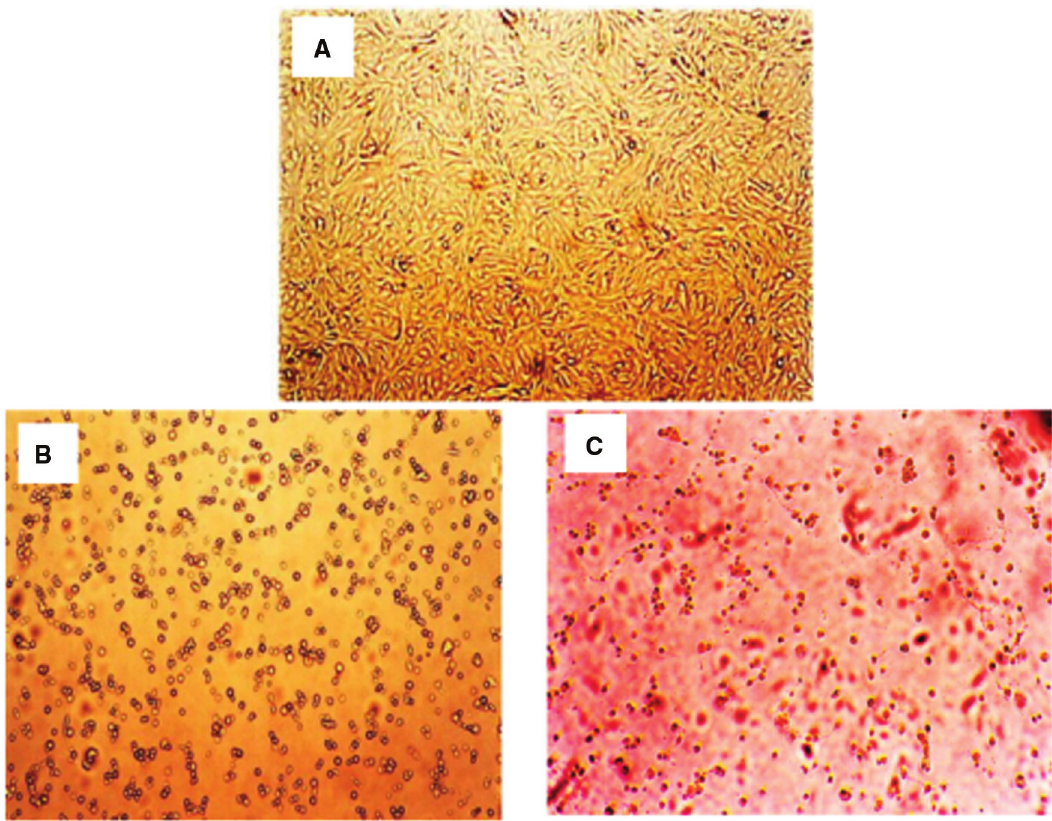
Figure 12 Microscopic morphology of (A) MCF-7 cells, (B) gold nanoparticle treated MCF-7 cells; and (C) bisdemethoxycurcumin analog (BDMCA)-functionalized gold nanoparticle treated MCF-7